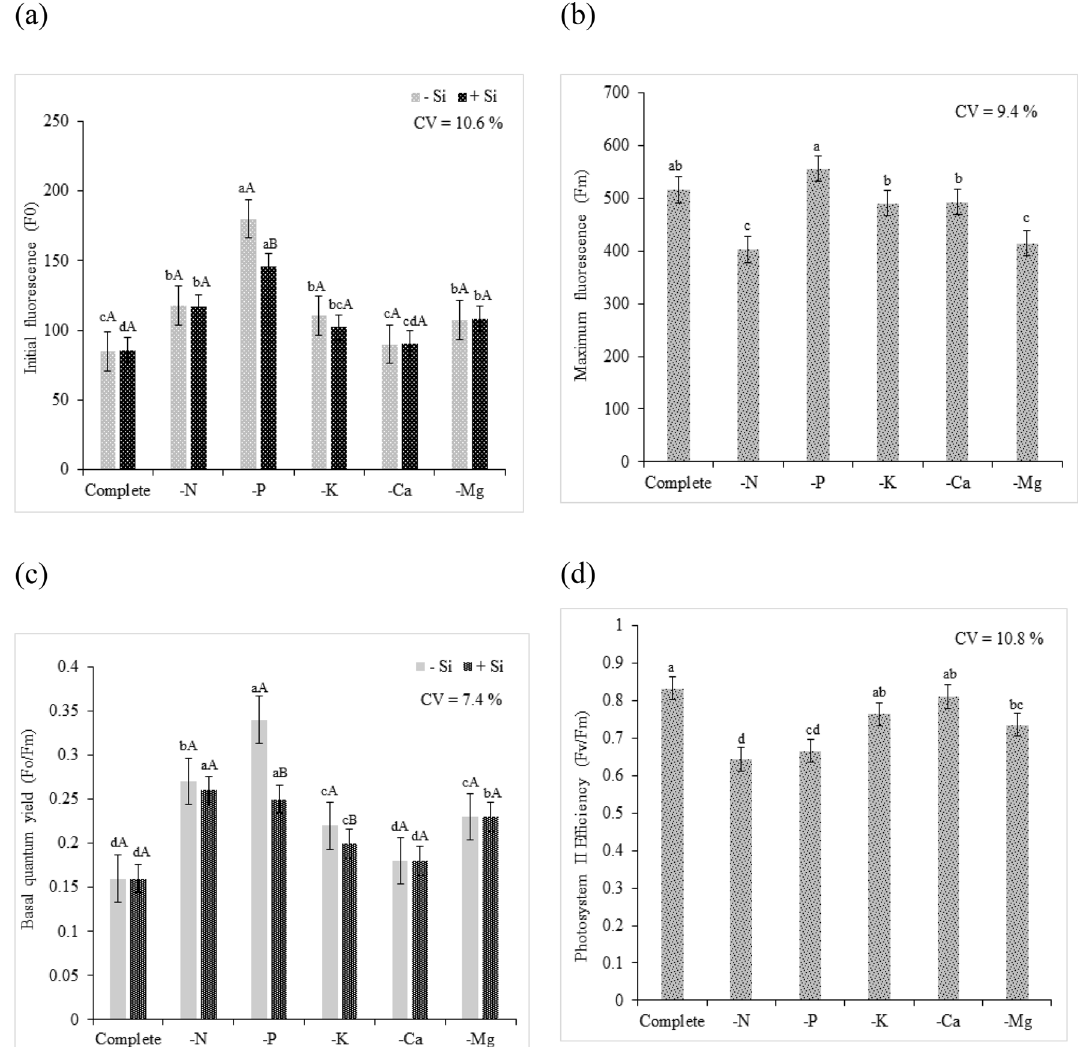
Figure 7. Physiological evaluations of quinoa plants in a Hoagland solution (Hoagland and Arnon 23 ) under omission of macronutrients in the absence (− Si) and presence of silicon (+ Si, ( a ) Initial fluorescence (Fo), ( b ) Maximum fluorescence (Fm), ( c ) basal quantum yield of Photosystem II, and ( d ) Photosystem II Efficiency. Equal lowercase letters demonstrate a similarity between the omitted and complete treatments by Tukey’s test at 5% probability. Equal uppercase letters show a similarity between treatments (− Si and + Si) by Tukey’s test at 5% probability. Software used to create this Figure was Microsoft Excel (v1804, https:// www. micro soft. stress limited the development of P-deficient plants compared to those grown in the complete solution (Fig. 8b). The scarcity of energy in plant metabolism compromises the biosynthesis processes 41,56 . Consequently, there is a decrease in the formation of phospholipids, which are essential cell membrane components. As a result, the synthesis of new cells decreases 57 , resulting in limited plant development. Potassium (K). Quinoa plants had a decrease in K accumulation of 94% and 93% under the absence and presence of Si, respectively, compared to that of plants cultivated in the complete solution (Fig. 4c). The Si sup- ply resulted in higher Si contents in plant shoots than that in the shoots of plants not supplied with Si (Fig. 4f). The symptoms of K deficiency included chlorosis only at the margins of older leaves, which was followed by necrosis (Fig. 3d,g,i). Low K availability promotes the decrease in protein synthesis, which is reflected in the accumulation of decarboxylated amino acids. This increases putrescine content, whose high concentrations accentuate cellular imbalance and promote marginal necrosis of plant tissues 58 . The GCI of K-deficient plants, regardless of the presence of Si, had lower intensity than that of plants grown in the complete solution (Fig. 5a). However, the Si supply reduced the depigmentation damage caused by K deficiency. This may have occurred due to the beneficial effect of Si in protecting the photosynthetic apparatus, which was corroborated by the decrease in F0/Fm the efficiency of Fv/Fm, allowing an efficient photosynthetic metabolism even with the nutrient deficiency (Fig. 7c,d).